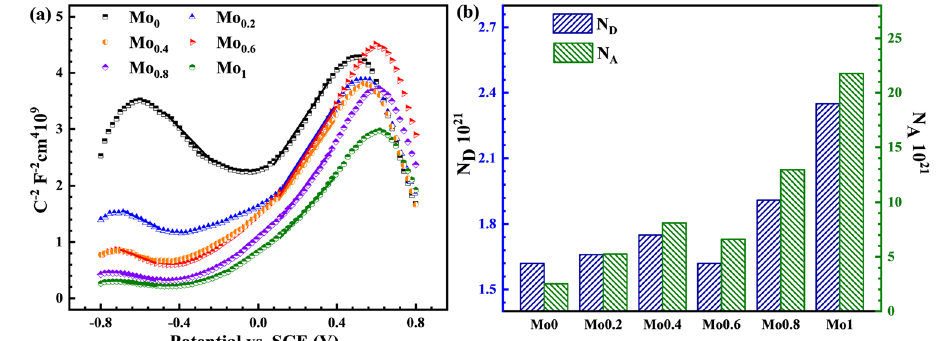
Fig. 6 Mott – Schottky results of the passive fi lms. a Mott – Schottky plots of the passive fi lm after the potentiostatic polarization at 0.4 V SCE for 10 h, b The donor (N D ) and acceptor densities (N A ) of the n-type and p-type semiconductors.